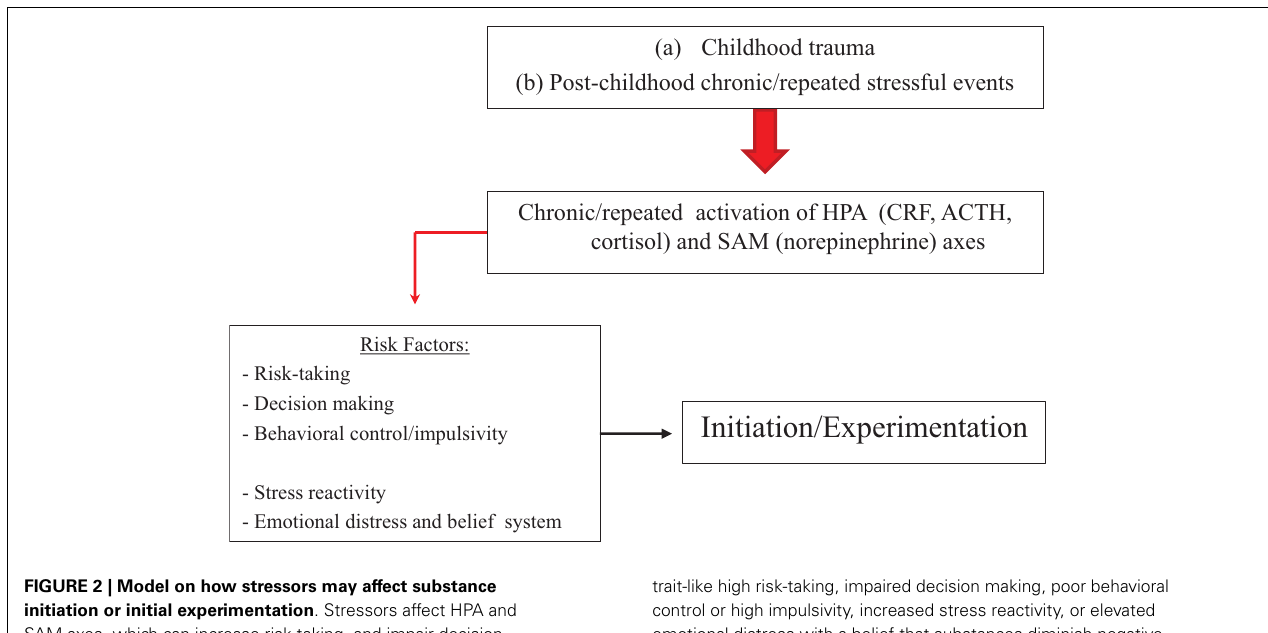
FIGURE 2 | Model on how stressors may affect substance initiation or initial experimentation . Stressors affect HPA and SAM axes, which can increase risk-taking, and impair decision making and behavioral control. At particular risk are people with